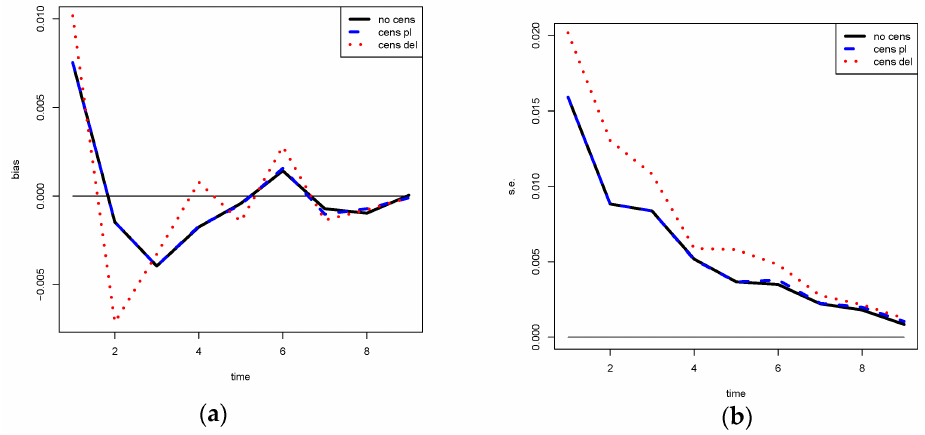
zoom of the tails of the previous plots. Figure 2. Bias ( a ) and standard ( b ) error for each of the three estimators.